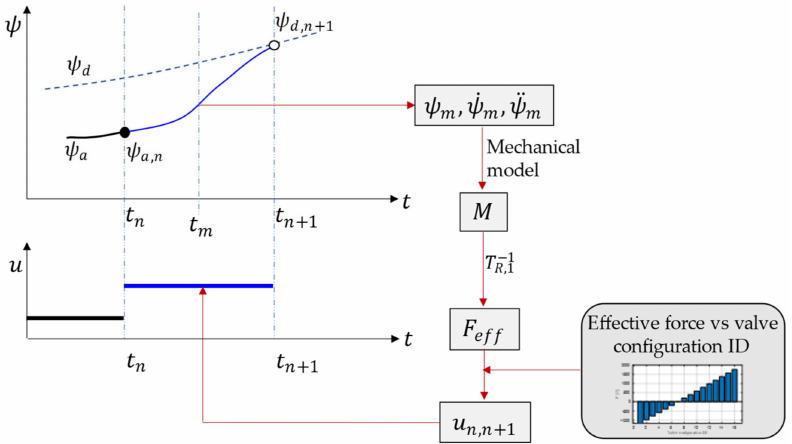
Figure 26. Illustration of the control strategy used in the swing phase of the gait